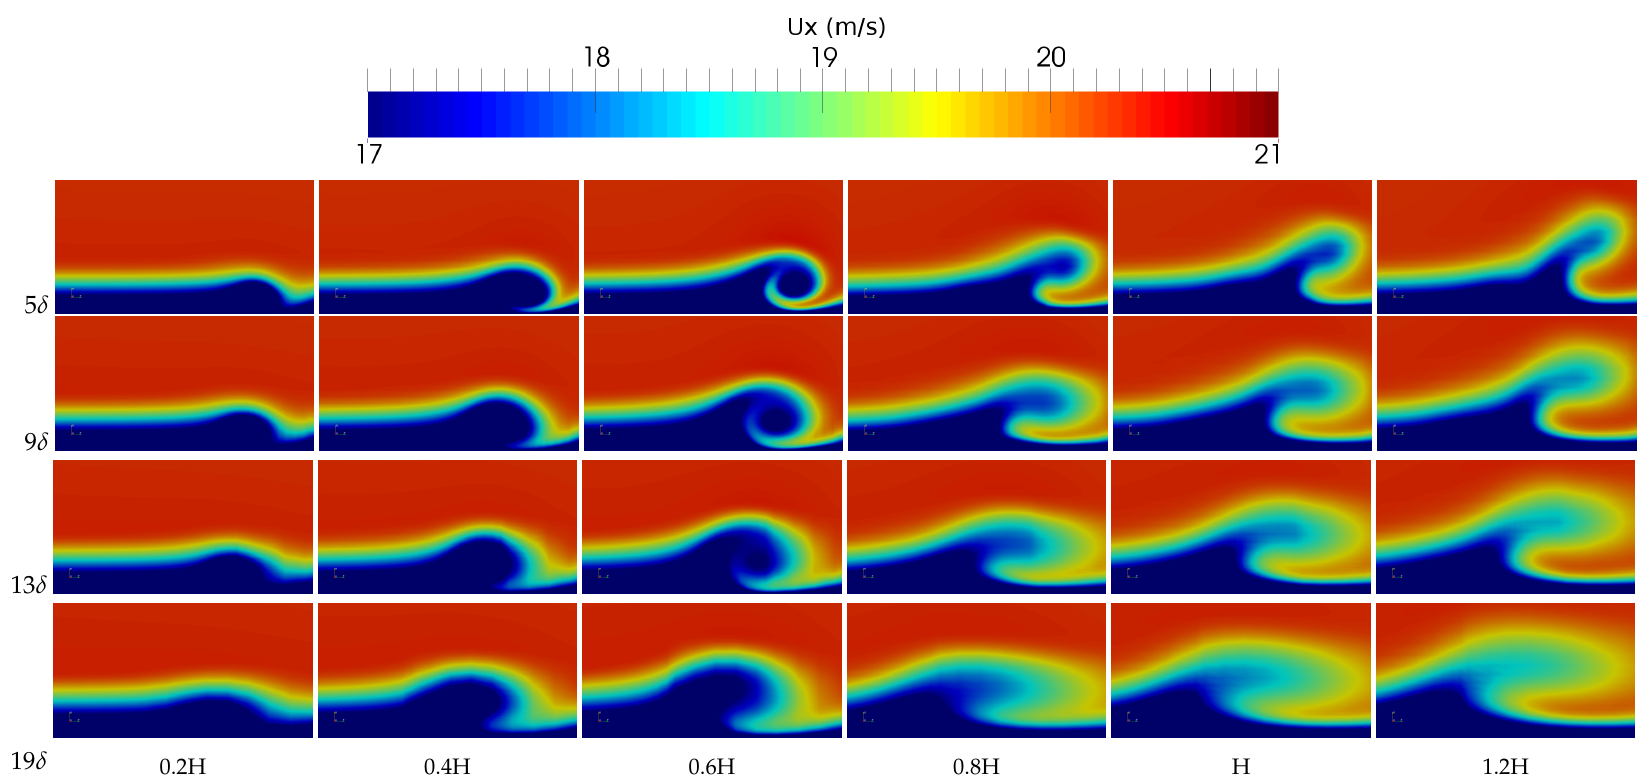
Figure A2. Axial velocity distributions Ux ms − 1 at four different planes normal to the streamwise direction and located at distances proportional to the local boundary layer thickness δ from the edge shown for six vortex generator heights (0.2H, 0.4H, 0.6H, 0.8H, H and 1.2H). Incident angle of β = 15 ◦